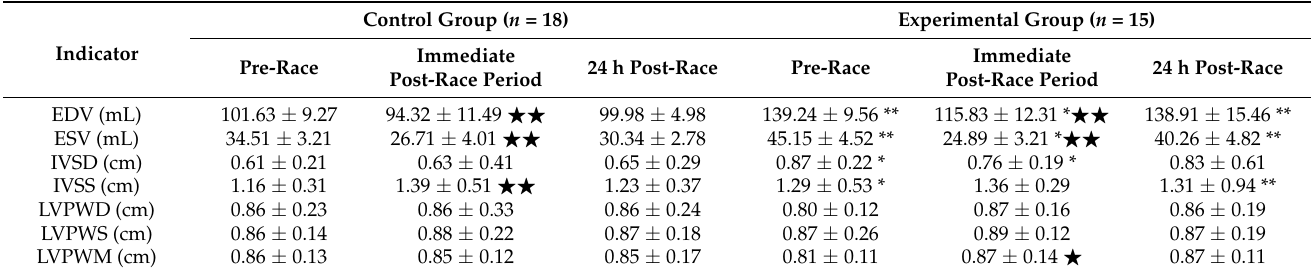
Table 2. Characteristics of changes in morphological indicators before, immediately after, and 24 h after the marathon.